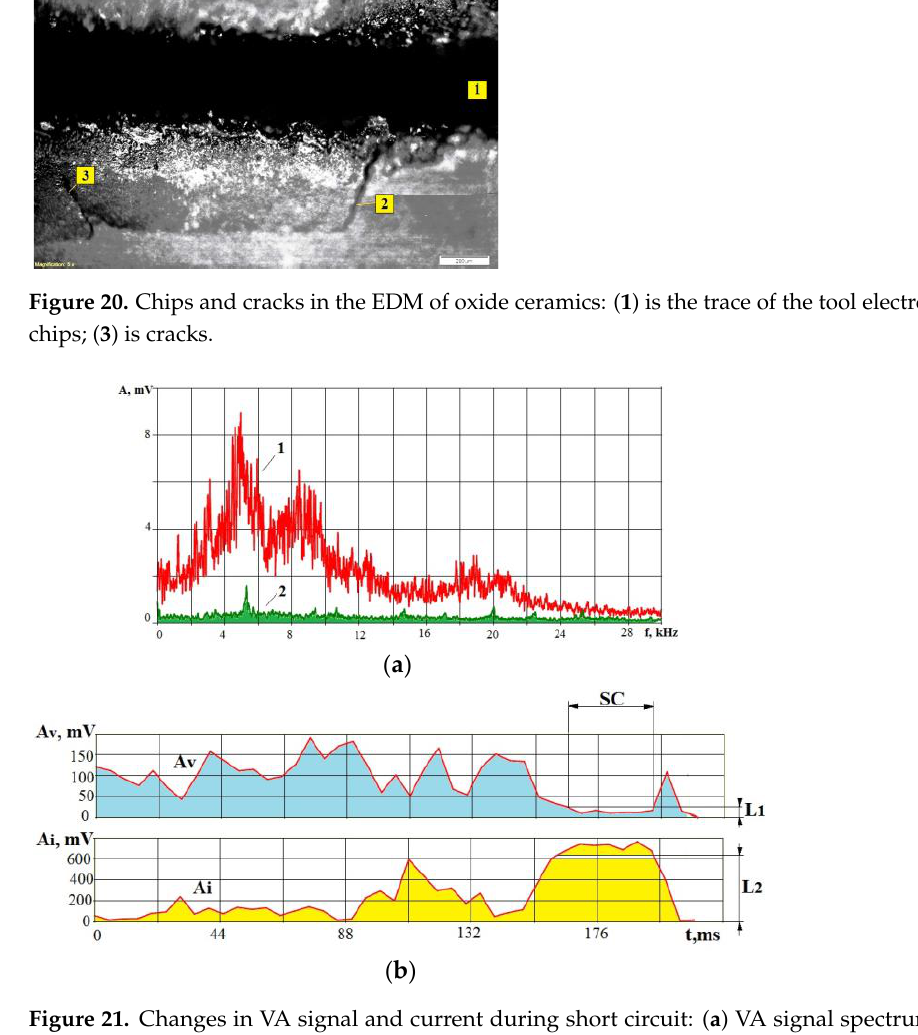
Figure 20. Chips and cracks in the EDM of oxide ceramics: ( 1 ) is the trace of the tool electrode; ( 2 ) is chips; ( 3 ) is cracks.